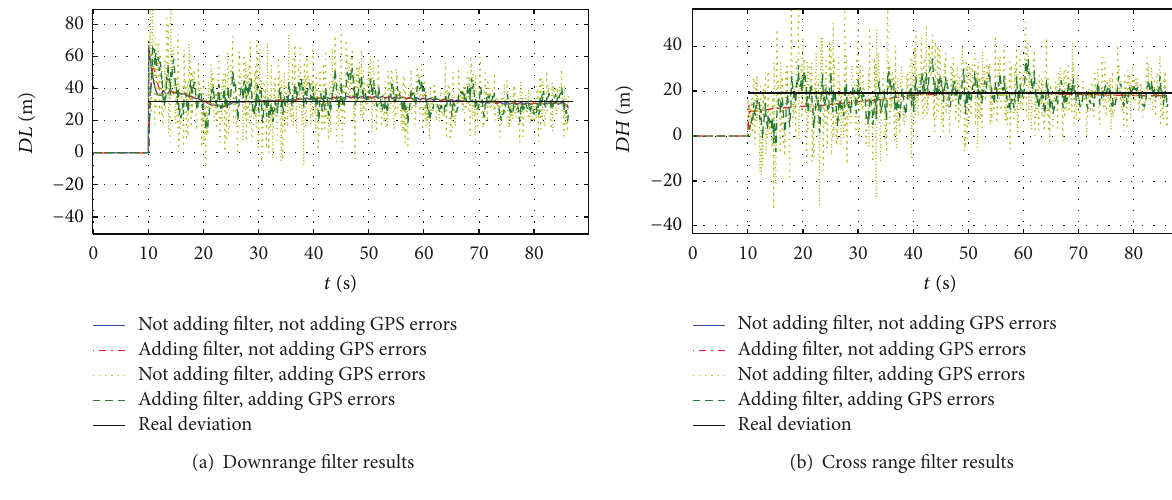
Figure 11: Results of second-order fading memory filter when fire elevation is 45.5 deg.